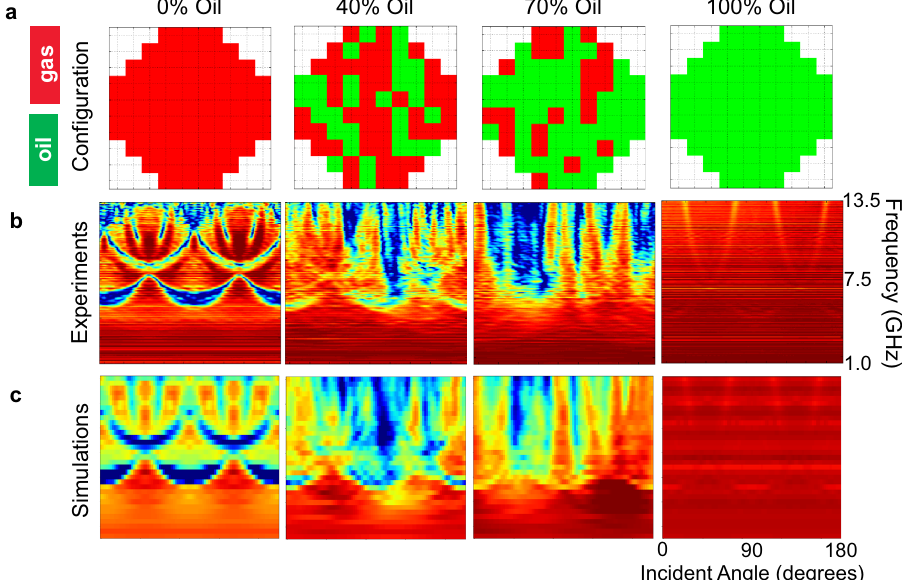
Fig. 2 Experimental and simulation contour plots at different oil/gas fractions. a Examples of the random con fi gurations of oil- fi lled holes in the photonic crystal block, with fi lling fractions (left to right): 0%, 40%, 70% to 100%. The remaining holes are fi lled with air. Green pixels represent oil- fi lled holes and red pixels represent air- fi lled holes. b Color contour plots from microwave transmission measurement on photonic crystal with oil- fi lling pattern corresponding to the con fi gurations in a . The contour plots are shown for the range of incident angle 0 – 180° ( x -axis) with a step size of 1°, and there are 201 discrete measurement frequencies along the y-axis from 1.0 to 13.5 GHz. The microwave transmission coef fi cient color scale is the same as that shown in Fig. 1. c Color contour plots from the forward model COMSOL simulation of microwave transmission on photonic crystal with oil- fi lling pattern corresponding to the con fi gurations in a . The contour plots are shown for the range of incident angle 0 – 180° on the x-axis with a step size of 2°, and there are 33 discrete measurement frequencies along the y -axis over the range 1.0 – 13.5 GHz. The microwave transmission coef fi cient color scale is the same as that shown in Fig.